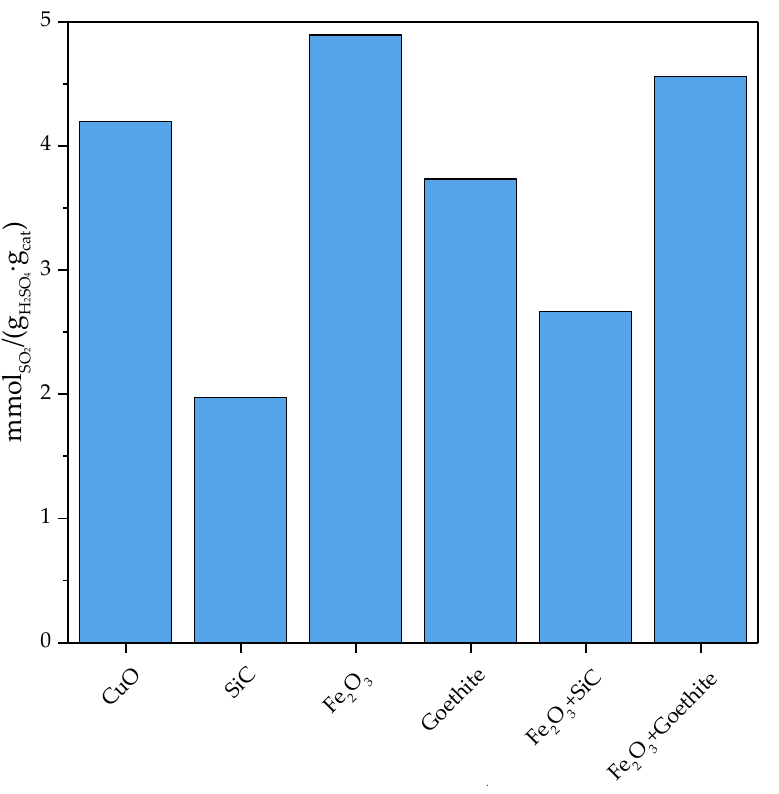
Figure 5. Total SO 2 efficiency of the catalysts studied (catalyst amount: 1 g; 1173 K). The characterization of initial and final catalysts of the Fe 2 O 3 as well as the goethite experiments were evaluated to determine the differences shown in their activities. Con- sidering the Pourbaix diagram of iron, Fe 2+ is the main species at acidic pH and 298 K in the water system. For that reason, the catalyst could suffer iron leaching during the process [26]. Therefore, the catalysts were characterized by the XRD analysis to determine the iron species, as shown in Figure 6. In the case of Fe 2 O 3 , the catalysts presented the same peaks before and after the reaction. These results indicate that the catalyst had the same crystalline phase at the end of the reaction, specifically, that of hematite form. Regarding of reaction, the goethite was transformed due to the reaction conditions (mainly, the high temperature and its possible reaction with steam). After the reaction, goethite presented a similar crystallinity to the Fe 2 O 3 sample